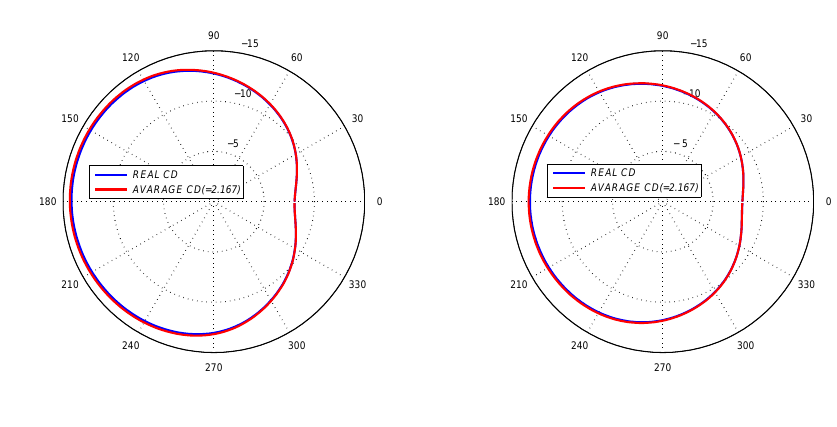
Therefore, we conclude that the mean ballistic coeffi- cients are quite suitable for re-entry predictions of objects with low-eccentricity orbits. The change with altitude in the drag coefficient should be considered, if more accurate predictions are required for the objects with nearly circular orbits.